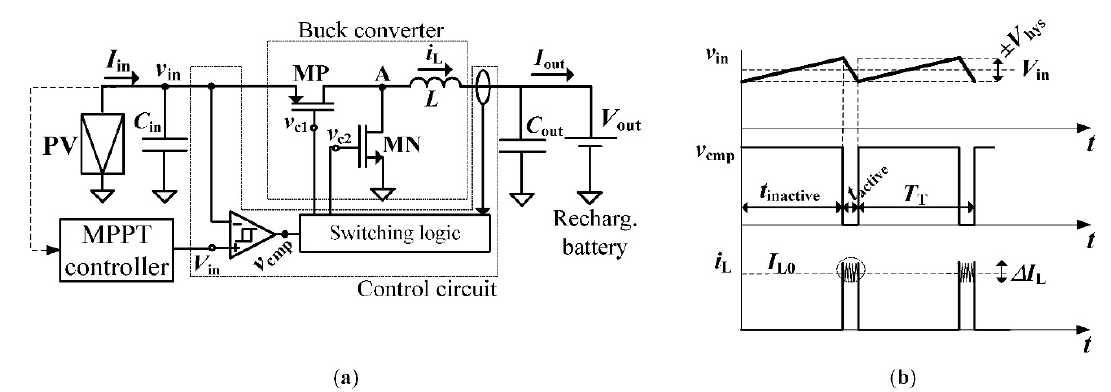
Figure 1. ( a ) Power processing circuit for a low-power PV module based on a synchronous buck dc/dc converter; ( b ) resulting waveforms when the converter operates in BM.